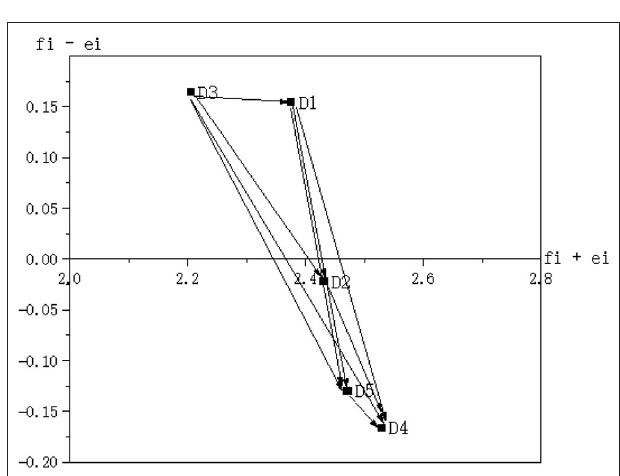
FIGURE 1 | Influence relation map of dimensions affecting public-public collaboration for food safety risk